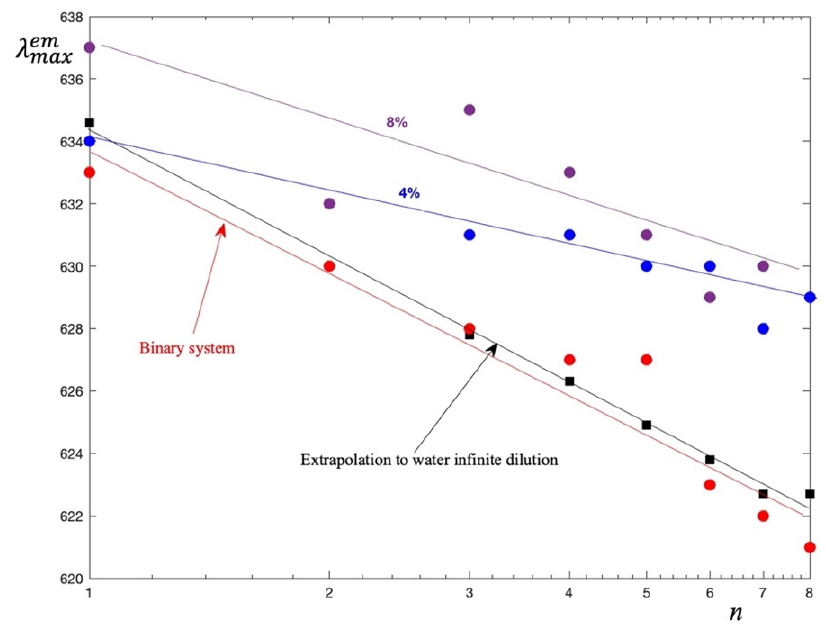
Figure 10. Fluorescence emission values obtained by dissolving NR in alkanols at different carbon numbers H − (CH 2 ) n − OH ( n = 1–8) compared with the same samples in the presence of 4% and 8% water.